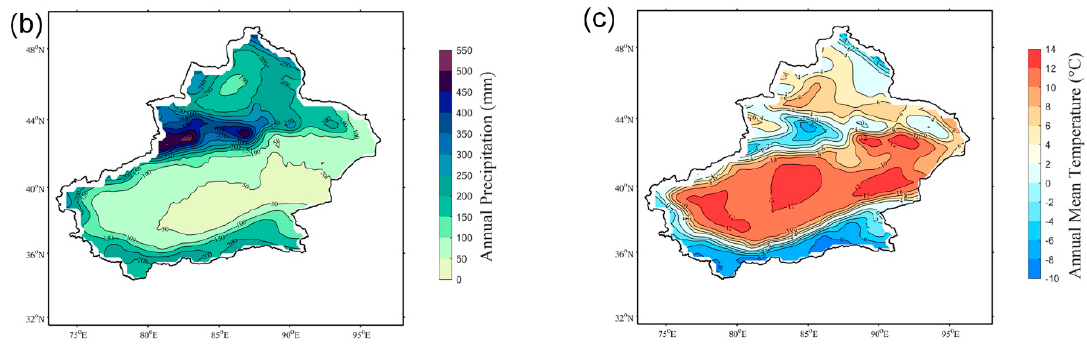
Figure 1. Study area. ( a ) Distribution of meteorological stations, ( b ) annual precipitation (mm), ( c ) annual temperature (°C).